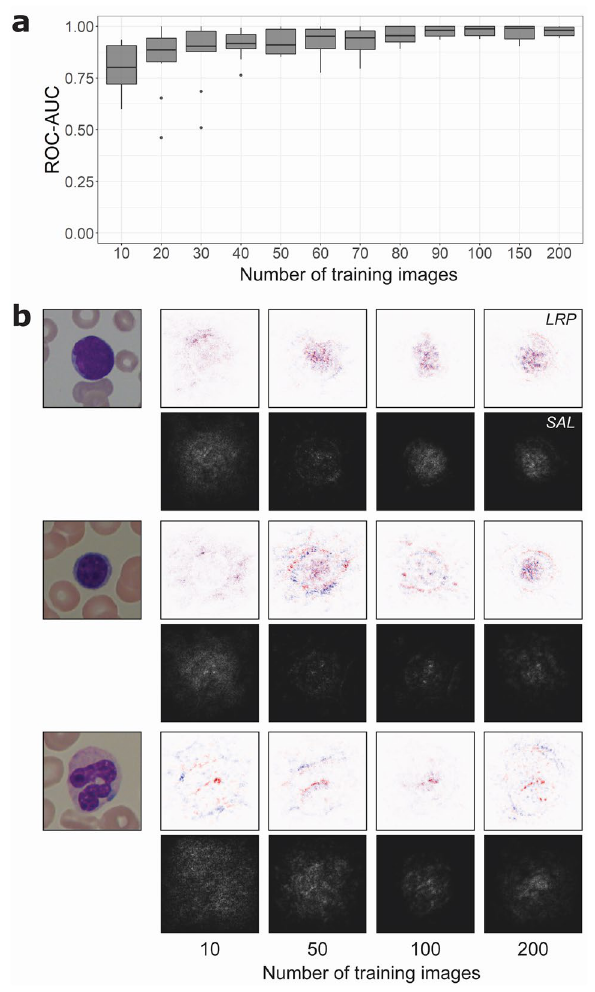
Figure 4. Lymphoblast classification performance and analysis as a function of training images from the ALL dataset. ( a ) Starting with ten training images, in each step ten images are added to the training set and the network is trained from scratch. The ROC-AUC of this network is calculated, and the process is repeated ten times so that all 250 images are at some point used as a training and validation set. Boxes show median and 2nd and 3rd quartile, with whiskers indicating the highest and lowest point within 1.5 times the interquartile range. Data points outside this range are considered outliers and visualized separately as dots. ( b ) Visualization with saliency maps (SAL) and layer-wise relevance propagation (LRP) when testing a lymphoblast (top), typical lymphocyte (middle) and segmented neutrophil (bottom) in networks trained on 10, 50, 100 and 200 images. In LRP, pixels visualized in red contribute positively to the final prediction, while pixels in blue carry negative relevance. In saliency maps, brighter pixels indicate a greater contribution to the final classification. Networks trained on 10 and 50 images seem to focus more on the surroundings of the leukocyte, while the networks trained on more images increasingly focus on the target cell itself and its nuclear